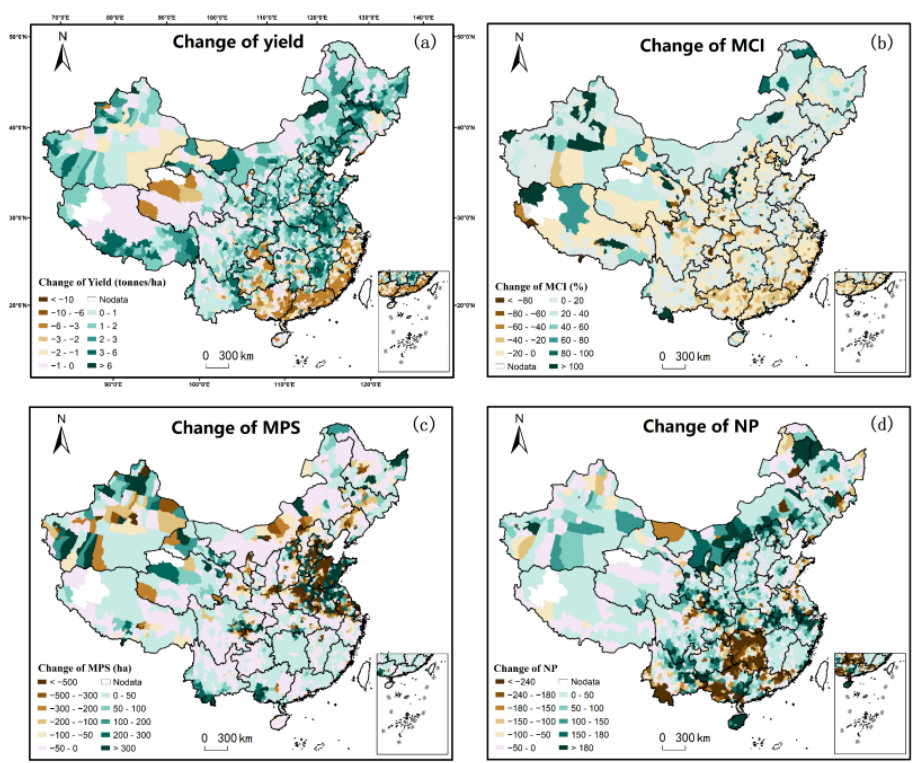
Figure 4. Characterization of change in four factors (( a ): yield, ( b ): multiple cropping index ( MCI ), ( c ): mean parcel size ( MPS ), ( d ): number of parcels (NP)) at the county scale across China between 2000 and 2010.